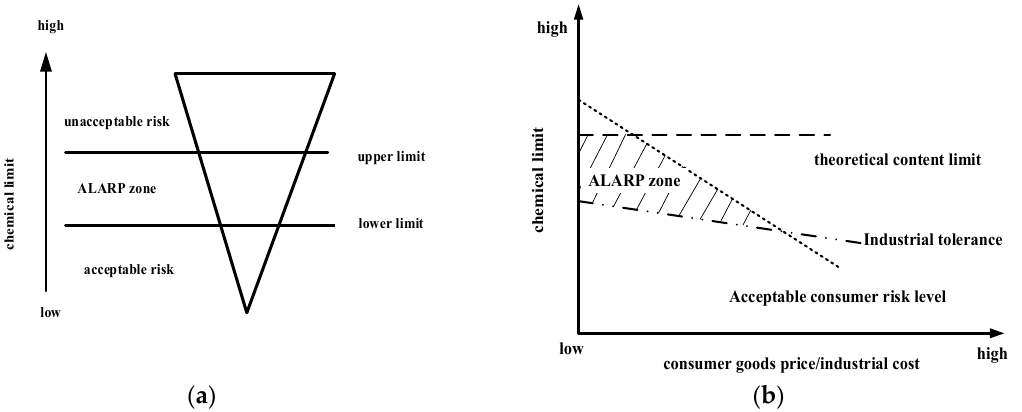
Figure 1. ( a ) Traditional ALARP principle; ( b ) ALARP principle for determining general chemical limits.